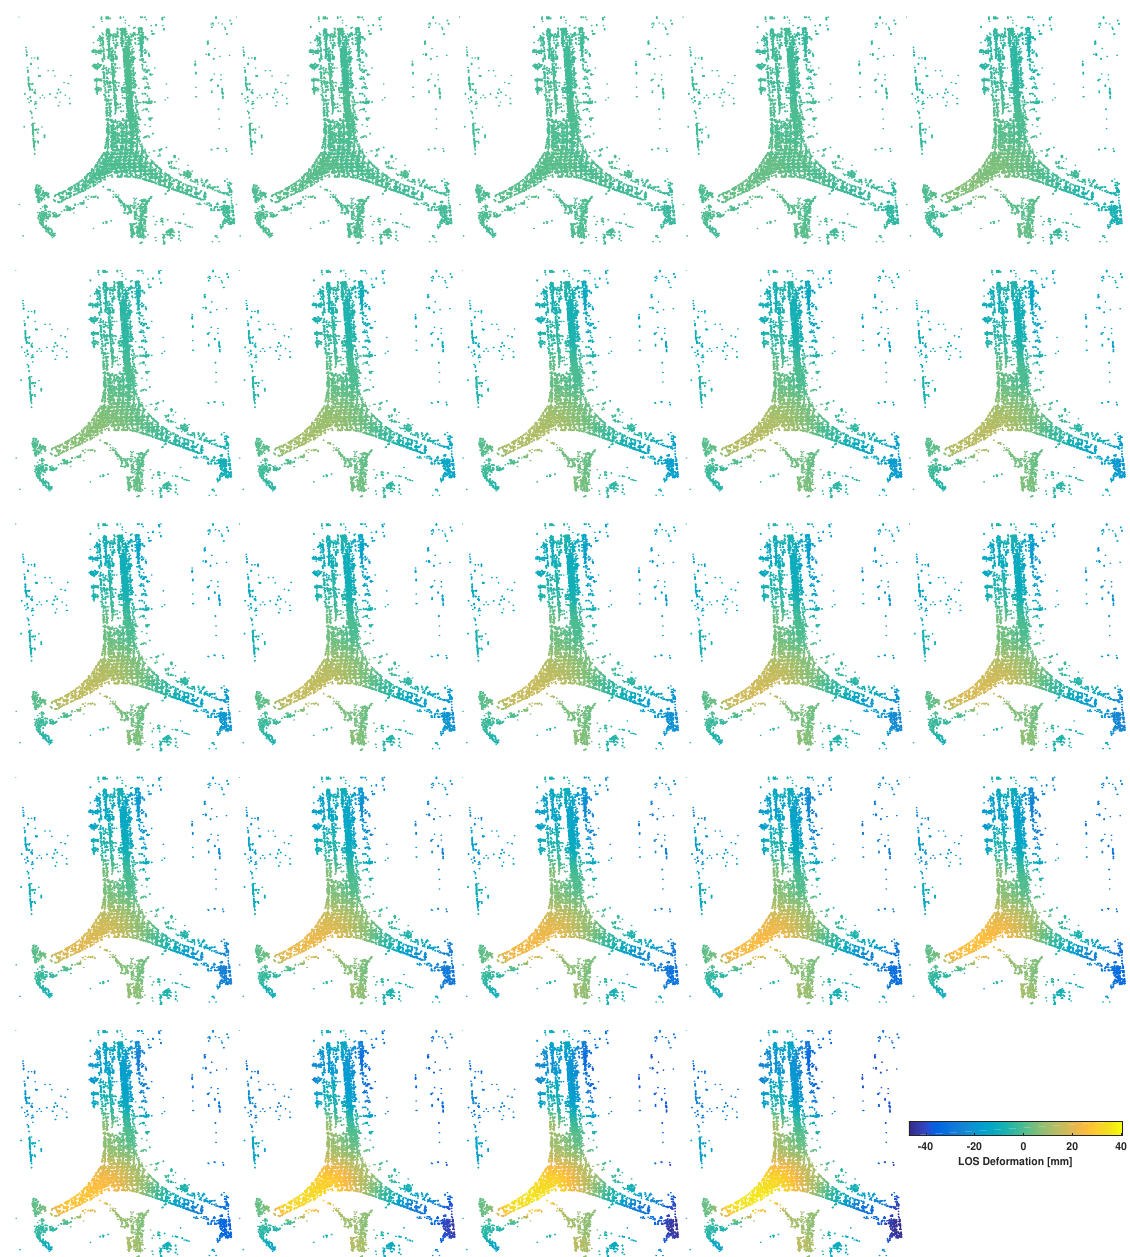
Figure 14. The LOS deformation time series over T3 E retrieved by the IStaMPS. All of the cumulative deformation maps are relative to the first image on 22 January 2012 and shown in SAR